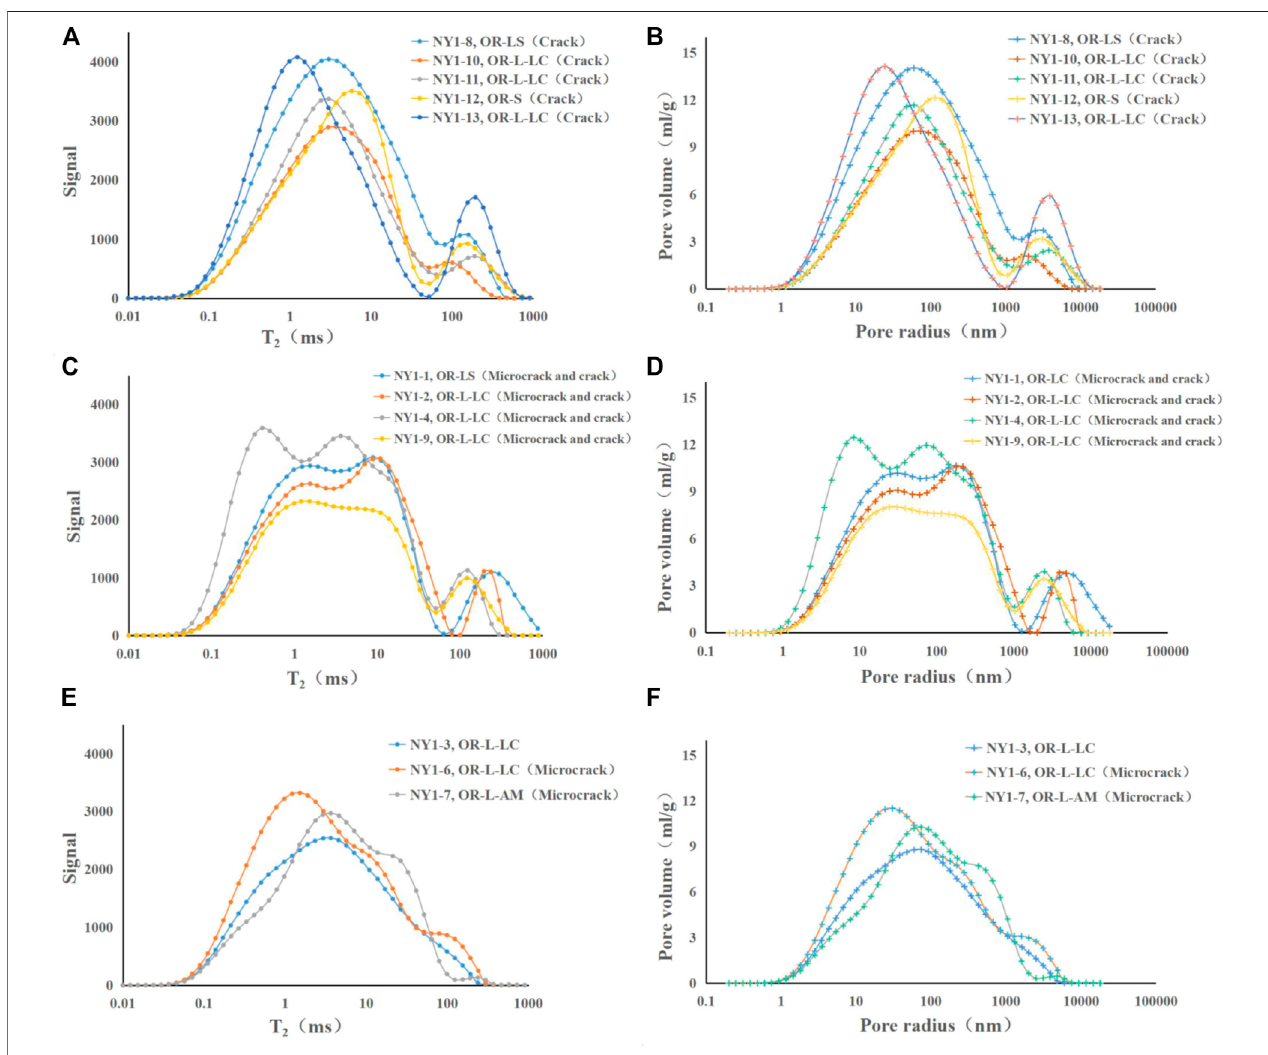
FIGURE 6 | NMR test signal distribution curves and pore structure curves. (A) Type I NMR test signal curve; (B) Type I pore structure curve; (C) Type II NMR test signal curve; (D) Type II pore structure curve; (E) Type III NMR test signal curve; f. Type III pore structure curve.